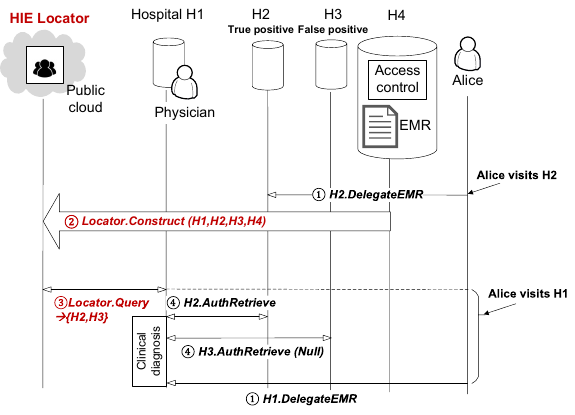
Figure 2. Data-sharing workflow in the HIE: The figure illustrates how Alice’s medical record (EMR) stored on Hospital H 2 is used. It shows the entire life cycle of this EMR: The EMR was produced when Alice paid a clinical visit to H 2 (1). During the current visit in Hospital H 1 , Alice’s physician requires accessing her EMR in H 2 (3). The physician first contacts the third-party locator service hosted on a public cloud (which is constructed at an earlier time (2) ) and obtains the list of candidate hospitals H 2 and H 3 . Here, H 3 is a noise for privacy preservation purpose. The physician then contacts both H 2 and H 3 , and find EMR on H 2 (4). Note that the physician can do so because she has the credential to access data on both H 2 and H 3 . For an adversary obtaining the list of H 2 and H 3 , she cannot distinguish which hospitals are noise as she does not have the